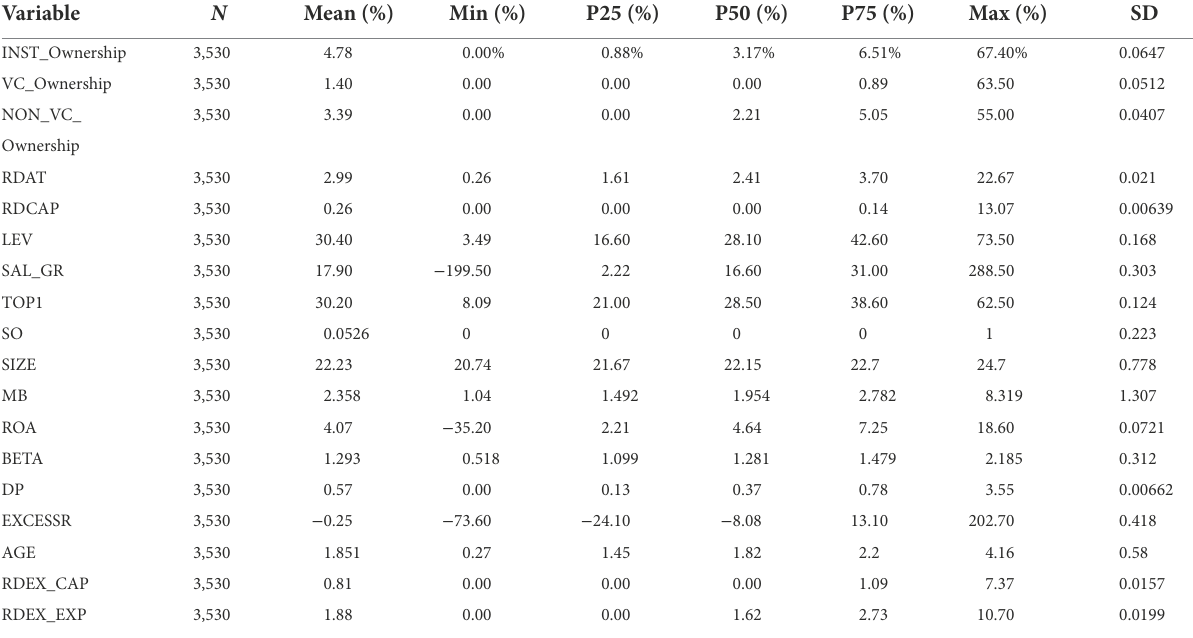
TABLE 1 Descriptive statistics of